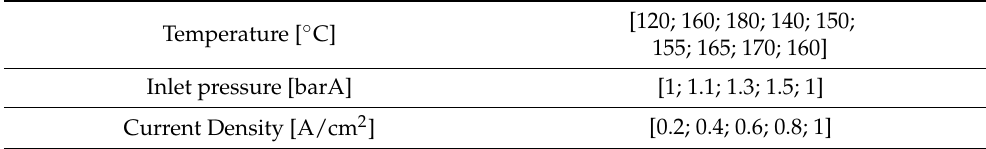
Table 1. The different operating conditions explored during the pressure and temperature design of experiments.